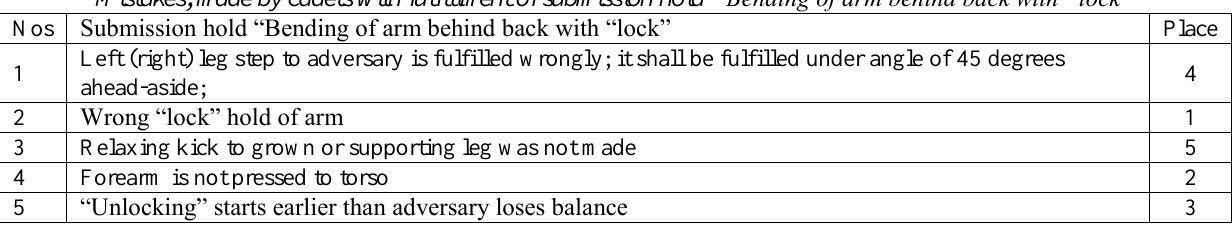
Mistakes, made by cadets with fulfillment of submission hold “Outside arm-bar”